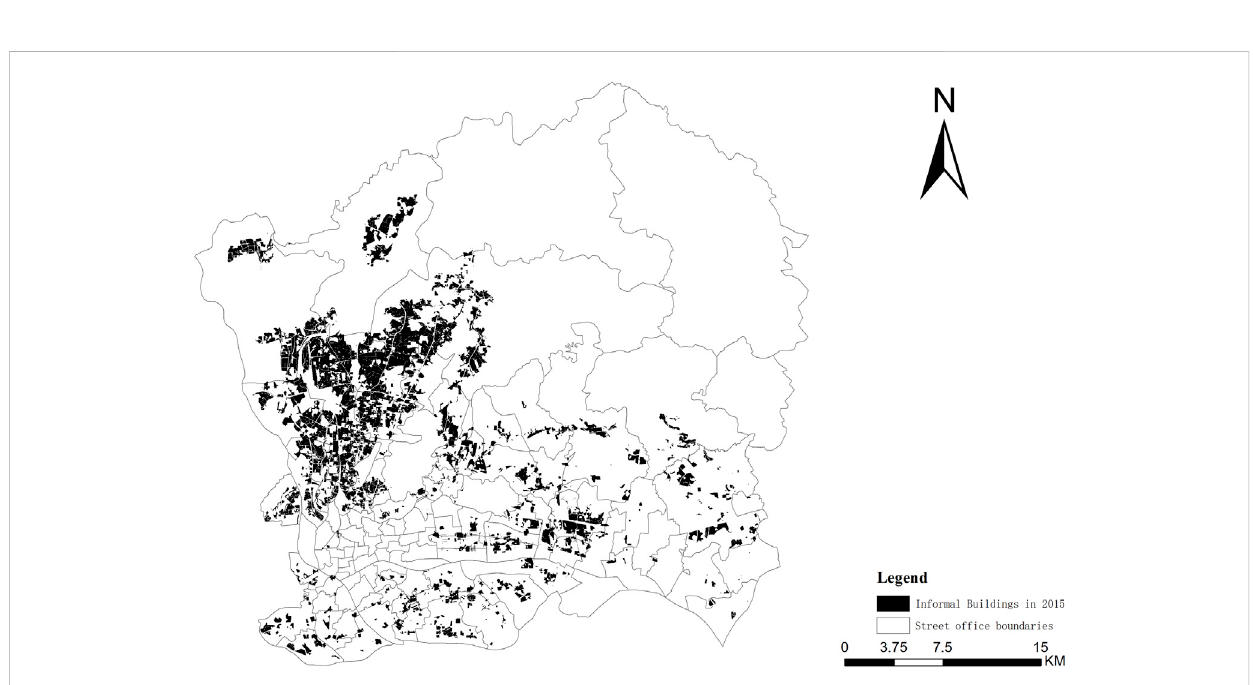
FIGURE 5 Spatial Distribution of urban villages in 2015 (Source: Drawn by the